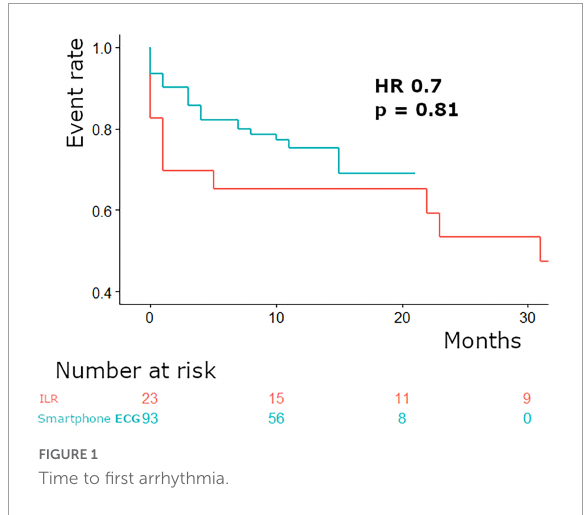
FIGURE1 Time to first